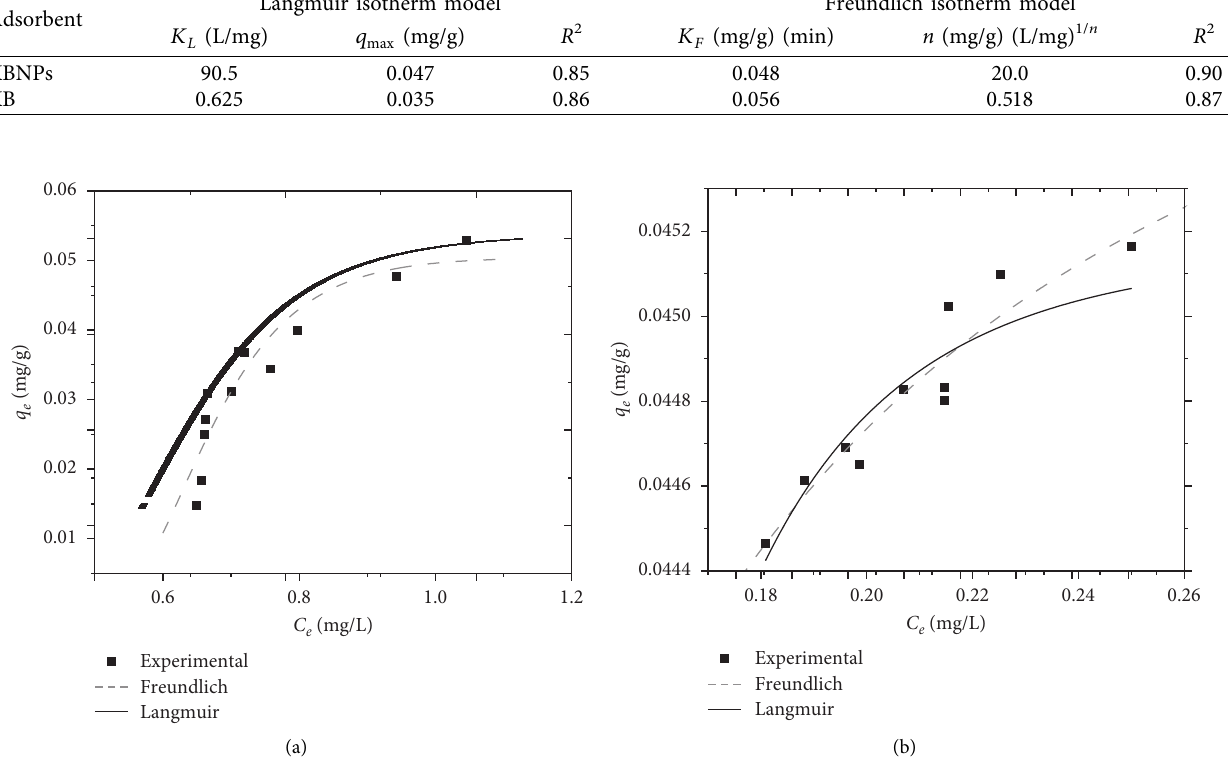
Figure 7: Isotherm model description for adsorbents: (a) KB adsorption and (b) KBNPs